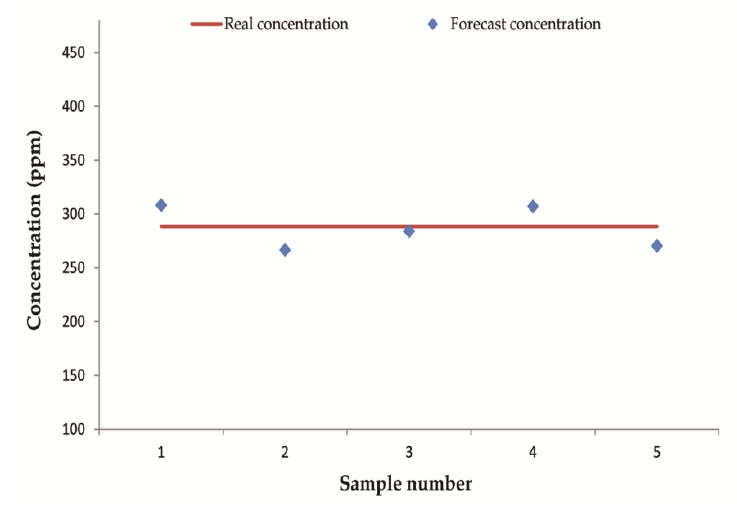
Figure 8. Repeatability test of 5 groups of ethanol.